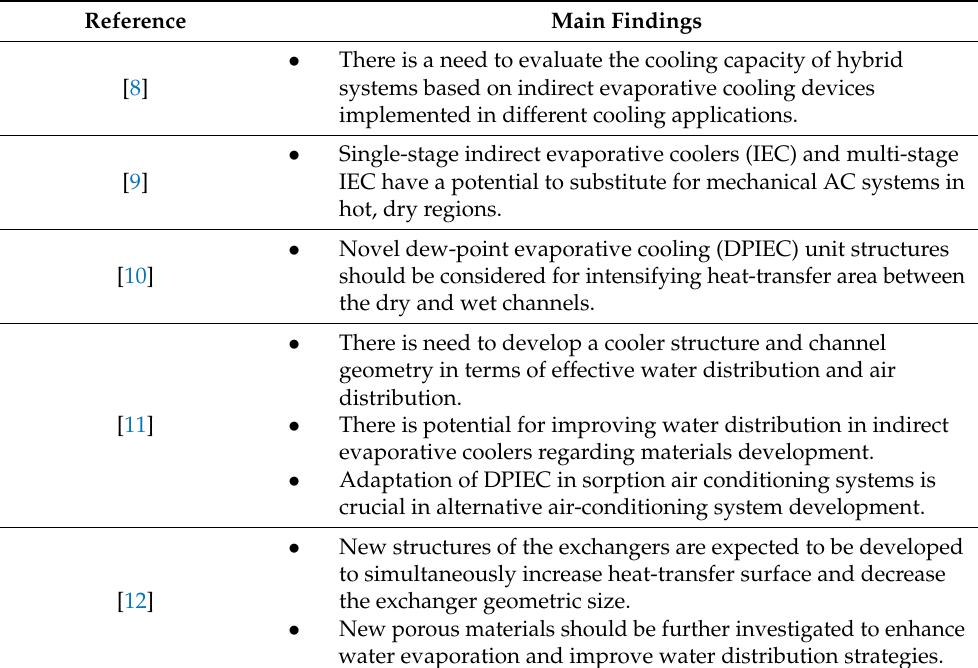
Table 1. Conclusions for future research based on recent literature reviews in the field of indirect evaporative